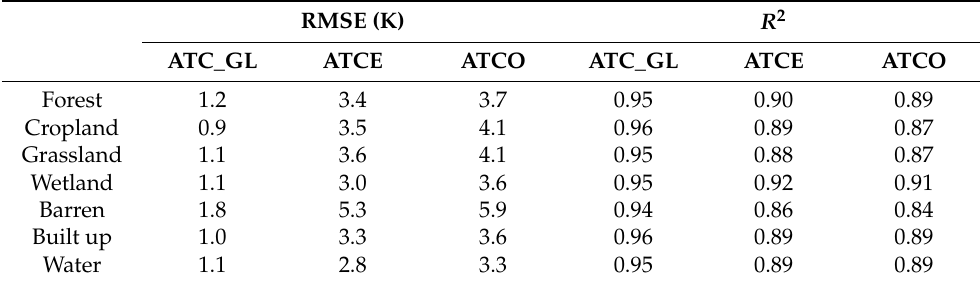
Table 4. The performances of the ATC_GL, ATCE, and ATCO over different land cover types. RMSE (K) R 2 ATC_GL ATCE ATCO ATC_GL ATCE ATCO Forest